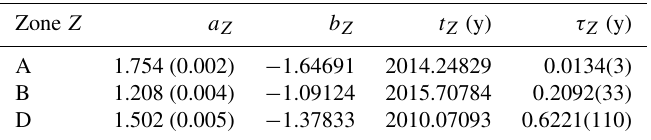
Table 3. Best fit parameters for the mutability of zones A, B and D after the main earthquake using the exponential trial function given by Eq. (6).